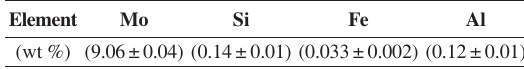
Table 1. Chemical composition of the Ti-9Mo samples. Element Mo Si